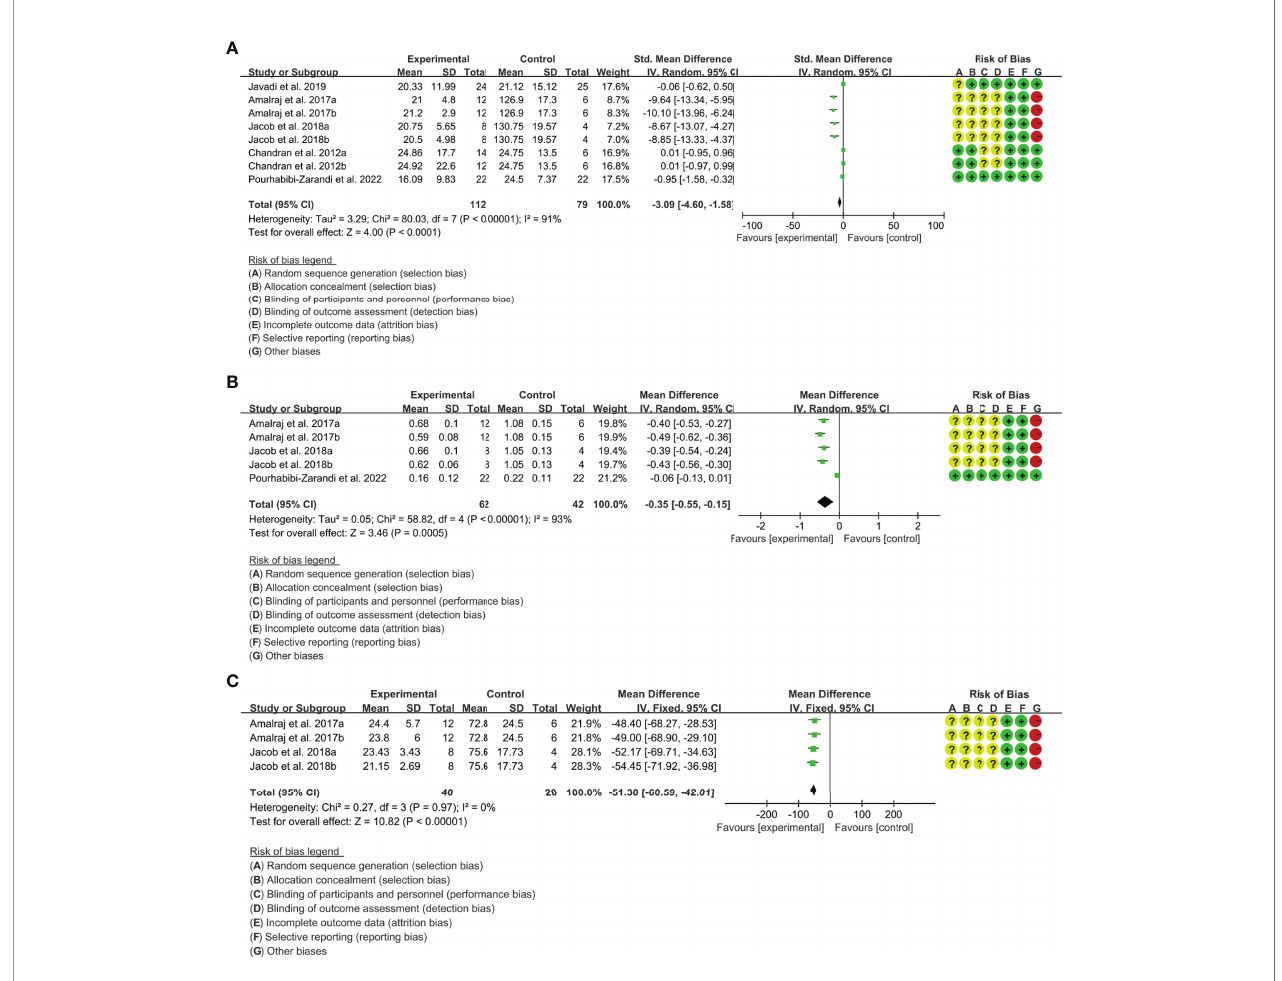
FIGURE 5 | The results of ESR (A) , CRP (B) and RF (C)